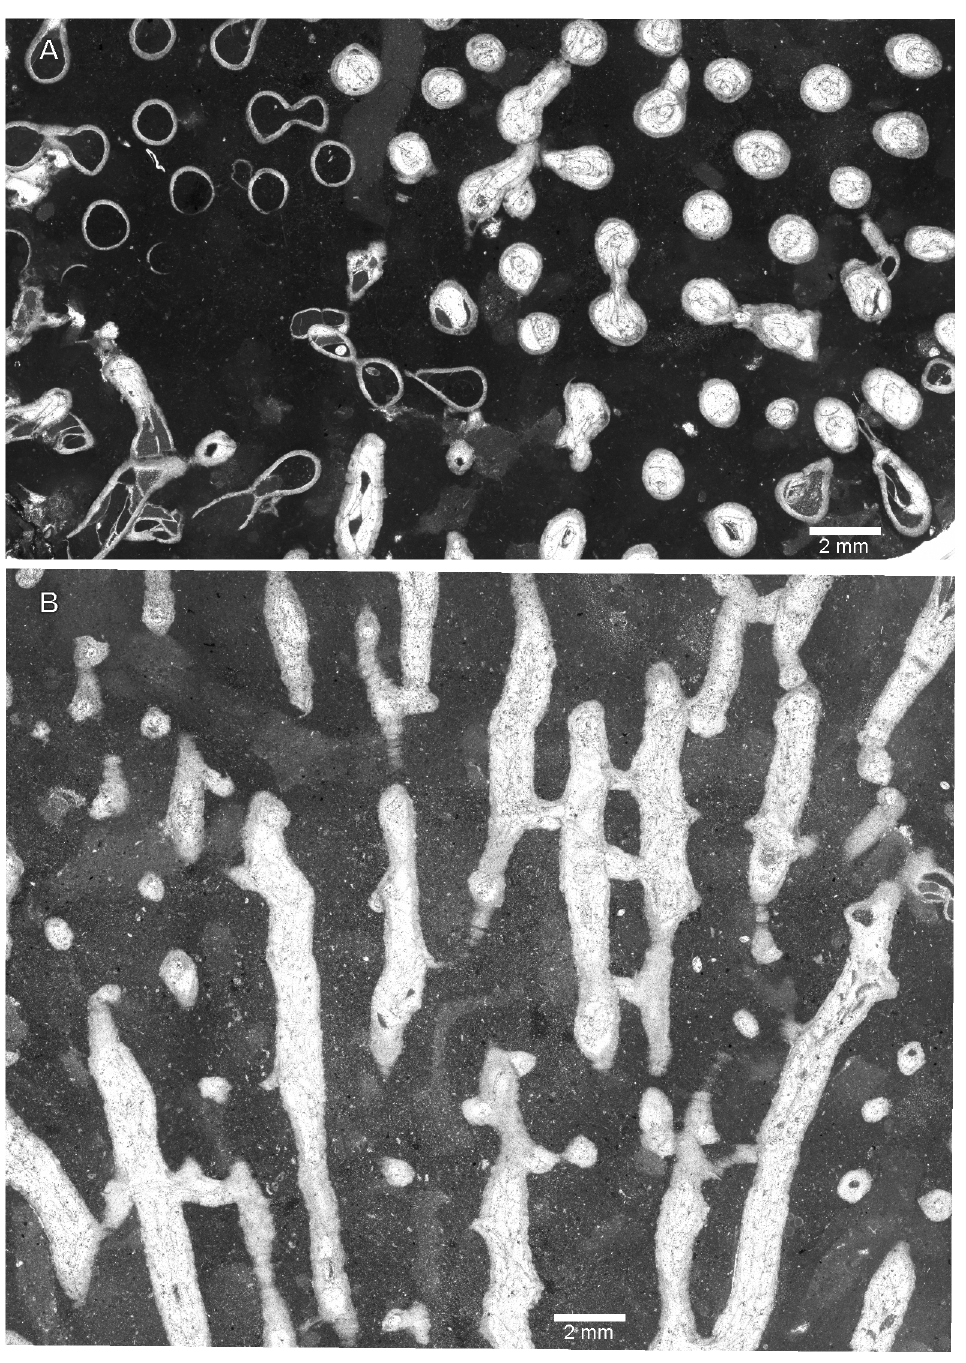
Fig 12. Syringopora hilarowiczi sp. nov. from Kowala Quarry, lithological set L, Upper Famennian. (A) Transverse section. (B) Longitudinal section. Specimen GIUS 3619 KF 006,